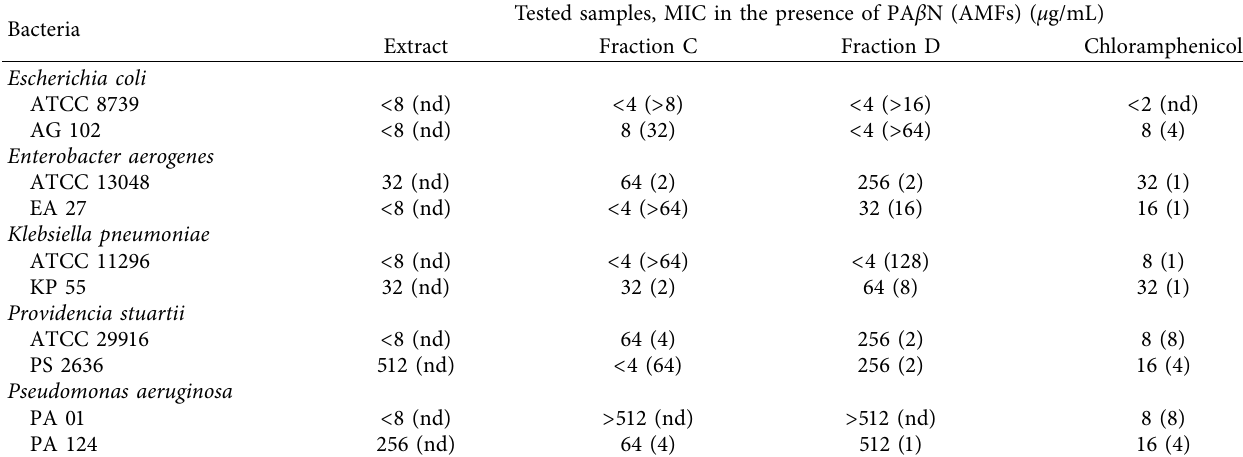
(-): ≥ 512 μ g/mL; MIC, minimum inhibitory concentration; MBC, minimum bactericidal concentration; 6, chrysoeriol; 11, 5,6-dihydroxy-7,3 ′ ,4 ′ -trime- thoxyflavone; 12, ladanein; 15, chrysoeriol 5- O - β -D-glucopyranoside; 16, 7- O -methyl luteolin 5- O - β -D-glucopyranoside; 17, luteolin 5- O - β -D- glucopyranoside. Table 3: MICs ( μ g/mL) of extract, active fractions of P. glandulosus and chloramphenicol in the presence of PA β N.